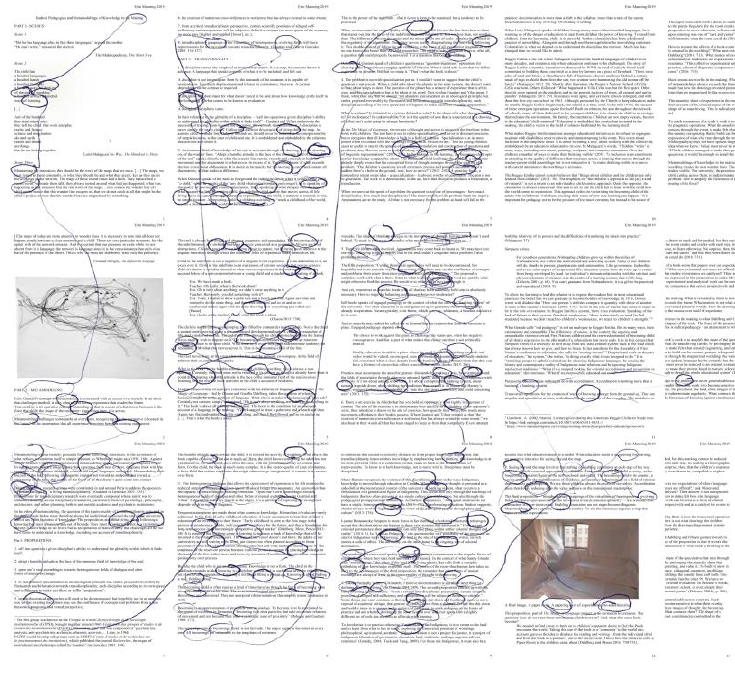
Figure 5 : Tracking the present continuous verbs Enabling constraint – conjunctions and definite